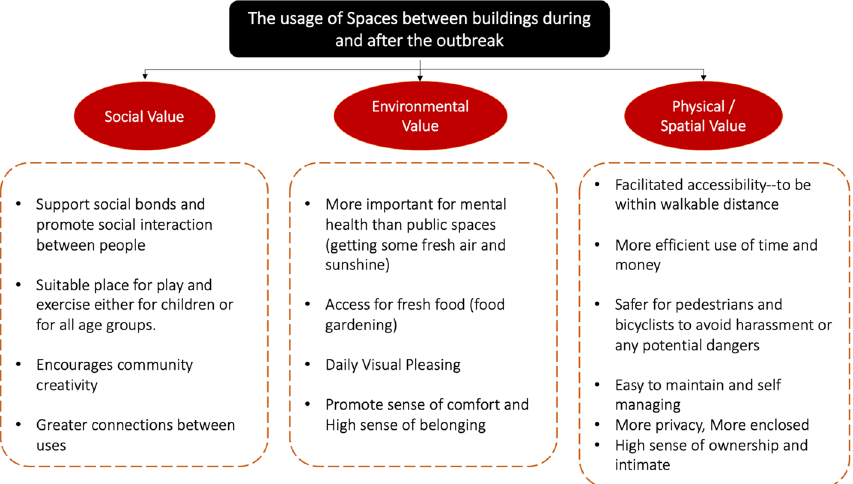
Fig. 9 The usage of spaces between